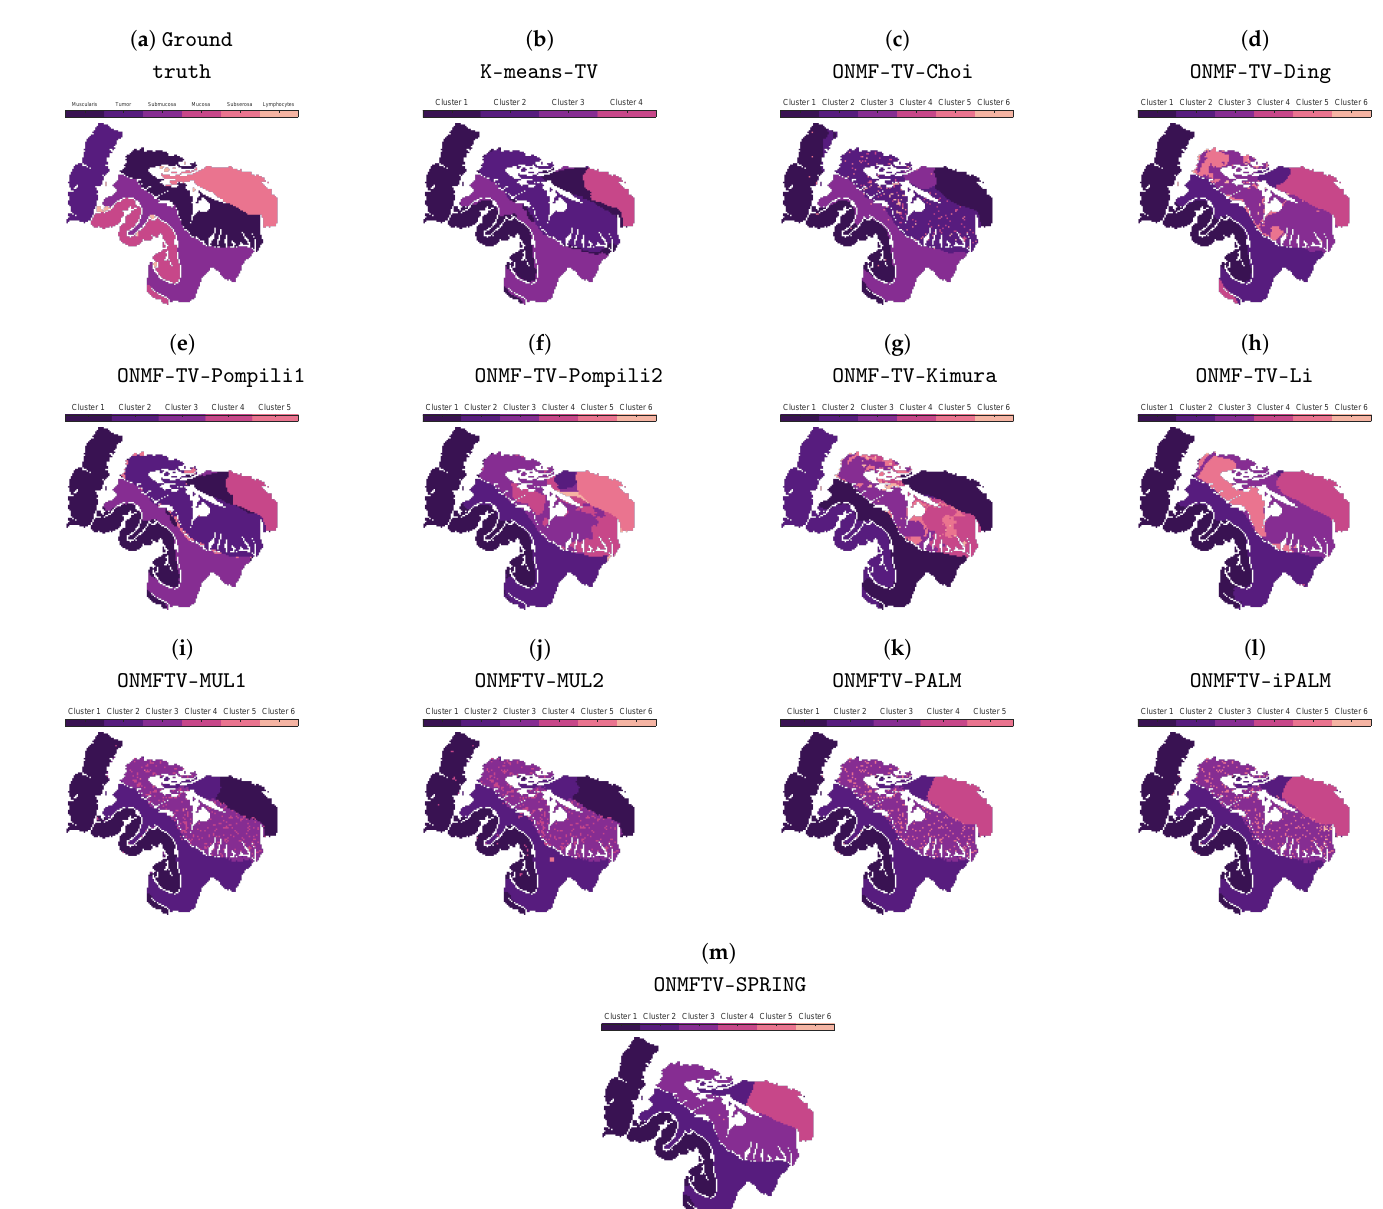
Figure 3. Ground truth and clusterings of all considered methods, including the TV regularization. The best-performing replicate, including the TV regularization, is chosen based on the normalized van Dongen